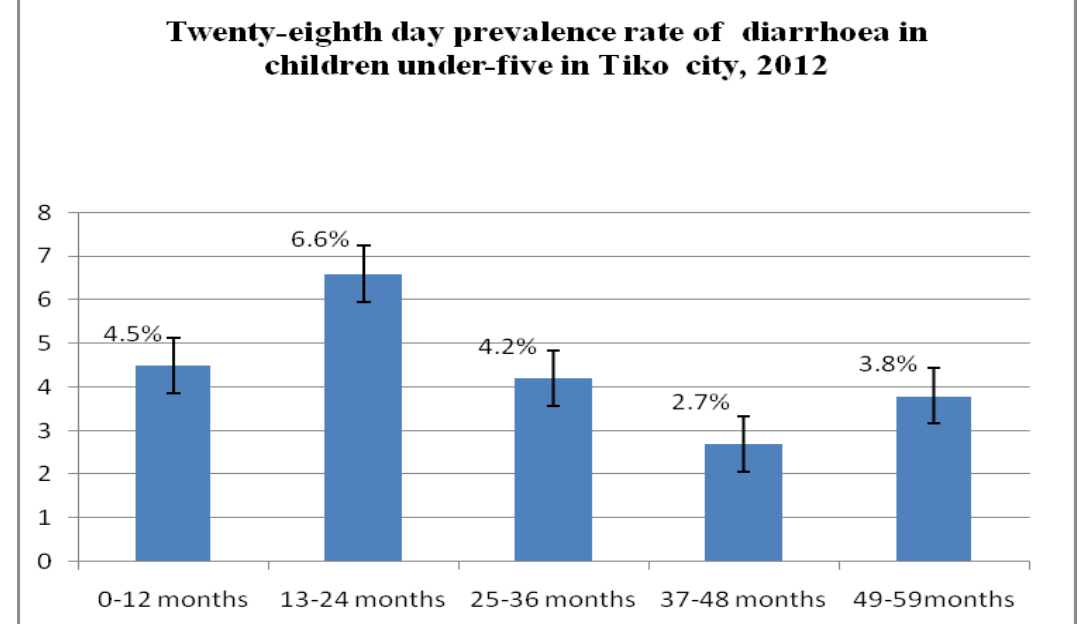
Figure 1. Twenty-eighth day prevalence rate of diarrhea in children under-five in Tiko City, 2012 ( n =